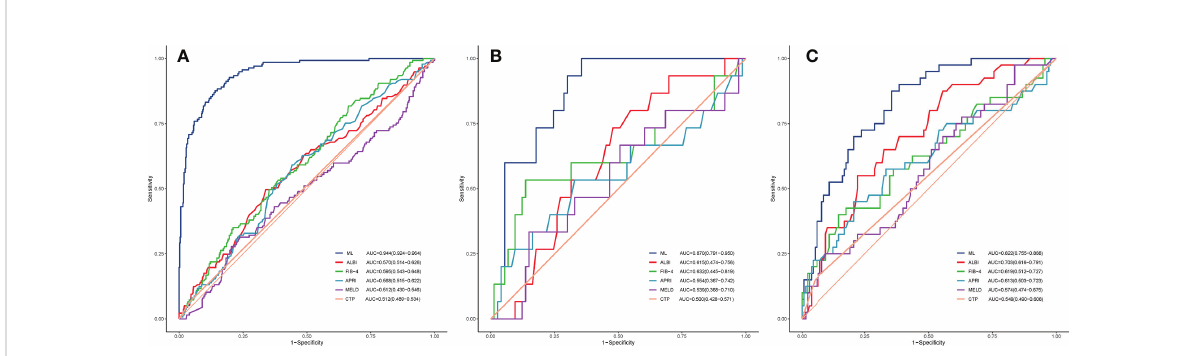
FIGURE 3 ROC curves. The ROC curves of the FIB-4 score, APRI score, CTP score, MELD score, and ALBI score are compared with that of the ML model in the training (A) , validation (B) , and testing (C) cohorts. ROC, receiver operating characteristic curves; ML, machine learning; FIB-4, fi brosis-4; APRI, aminotransferase to platelet ratio index; CTP, Child-Turcotte-Pugh; MELD, model for end-stage liver disease; ALBI, albumin – bilirubin.